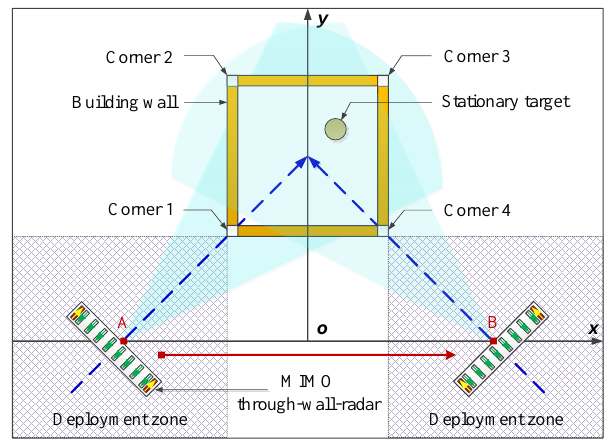
Figure 1. Single-side two-location spotlight imaging model based on multiple-input multiple-output (MIMO)